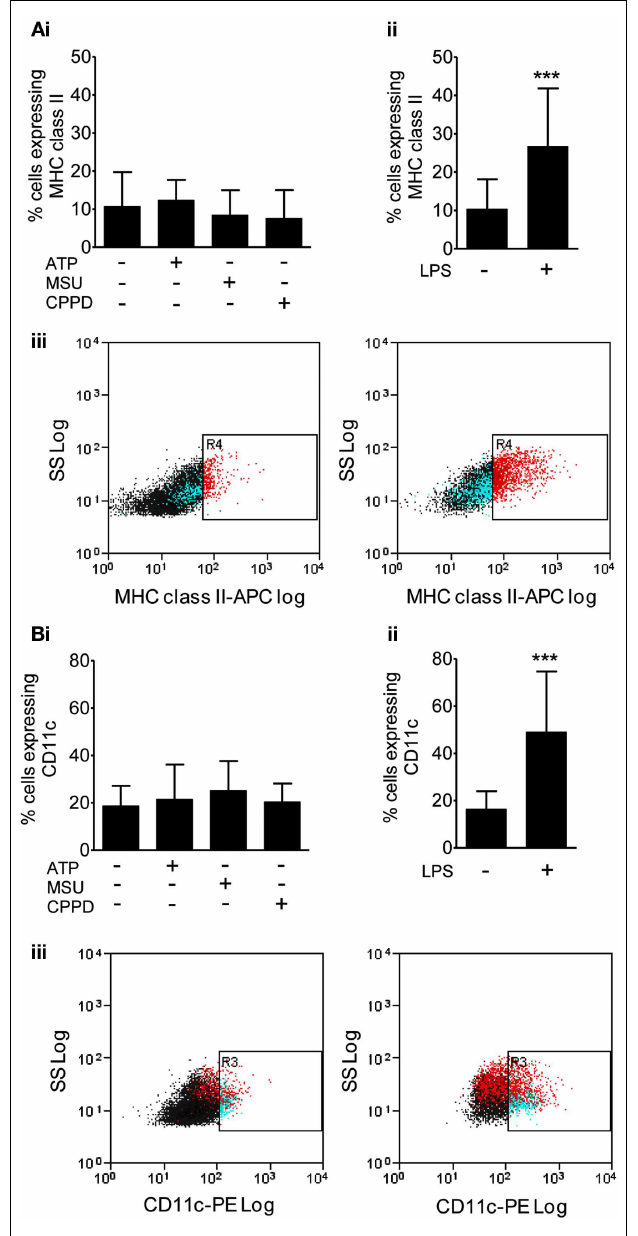
FIGURE 3 | Effects of DAMPs on surface marker expression in microglia cells. The expression of surface markers of microglia activation MHC class II (A) , and CD11c (B) were measured after 24h exposure to the NLRP3-activating DAMPs ATP (5mM), MSU, and CPPD [both 250 µ g/ml; (Bi) ] or the PAMP LPS [1 µ g/ml; (Bii) ]. Flow cytometry was used to quantify surface marker expression. Data are expressed as a percentage of cells that co-express CD45 and CD11b. Representative dot plots showing the CD45 and CD11b expressing cell population plus and minus LPS treatment are also shown (Biii) . Data are pooled samples from at least five separate experiments. *** P < 0.001 vs. untreated.